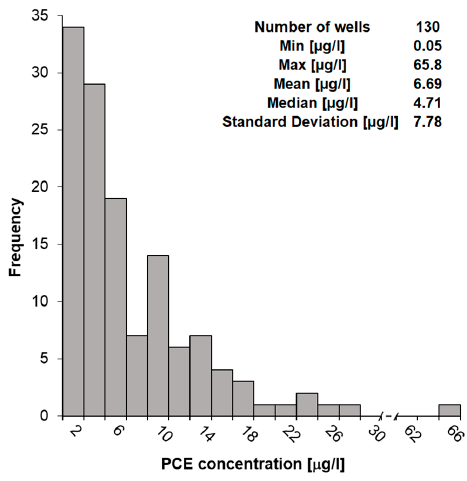
Figure 3. Frequency histogram of tetrachloroethylene (PCE) concentration.